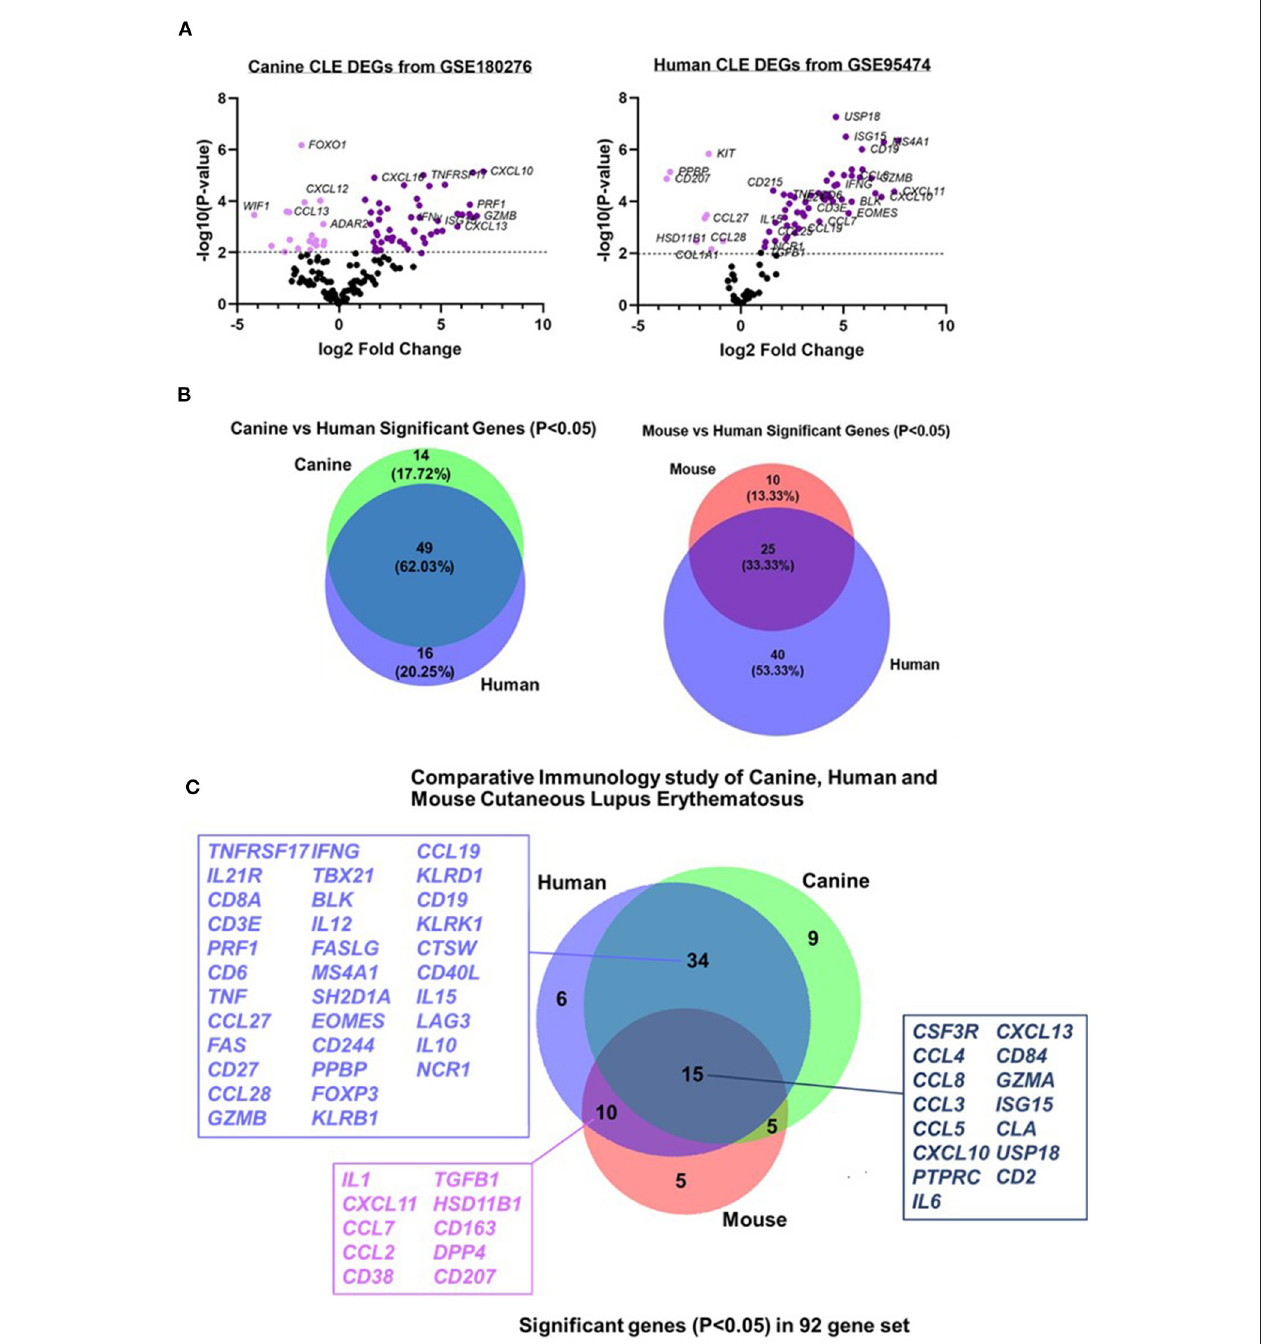
FIGURE 4 | Comparative transcriptomics of canine CLE cases with human and murine CLE. Volcano plots of (A) canine and human CLE differentially expressed genes from 160 gene common denominator set. (B) Venn diagram showing number of shared probes between canine and human CLE. (C) Venn diagram showing shared DEGs between canine, human, and murine